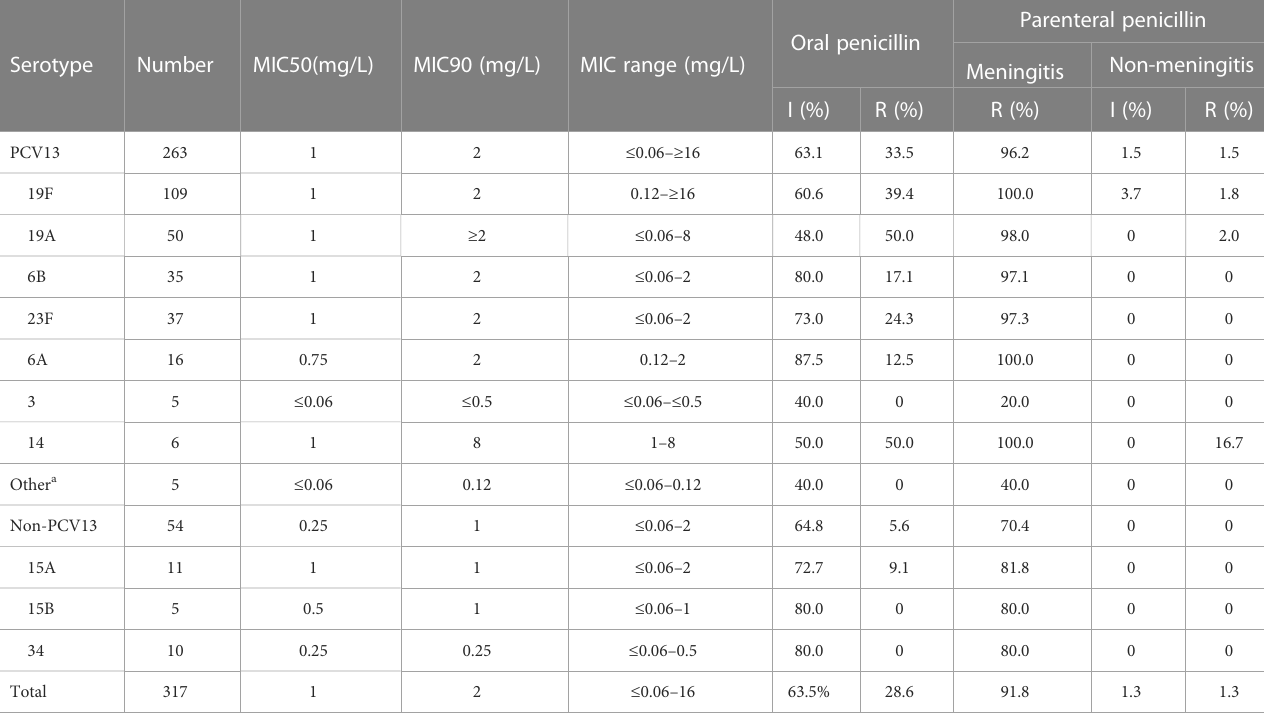
TABLE 3 Susceptibility of S. pneumoniae to penicillin according to serotype.